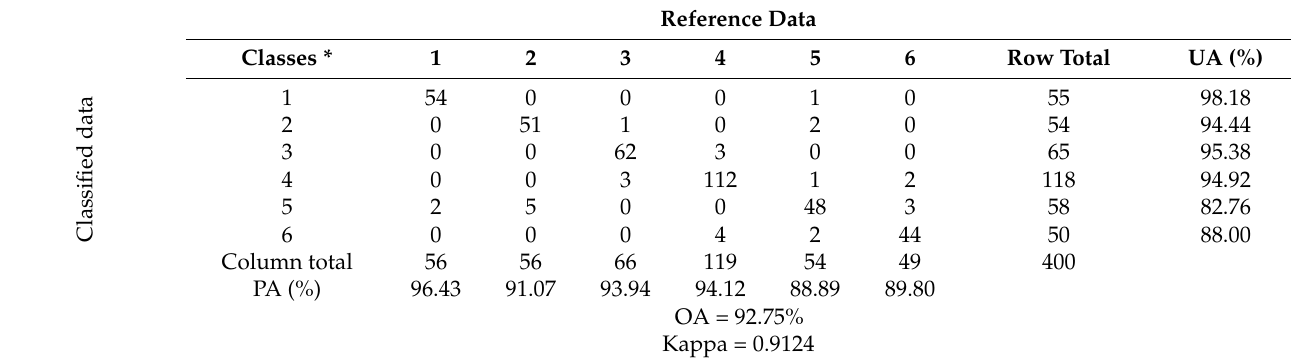
Table A5. Error matrix relating to accuracy assessment of the classified LULC map of